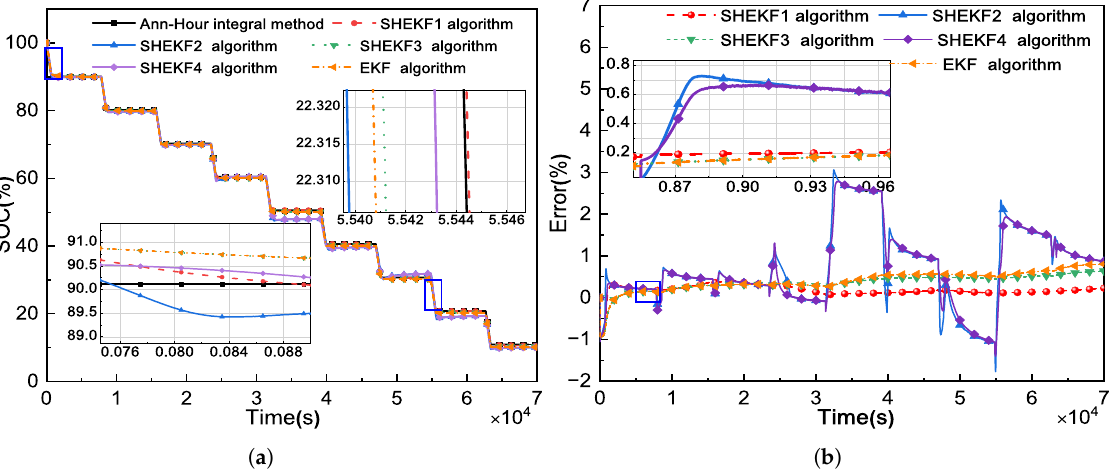
Figure 8. Algorithms comparison and its error curve with correct SOC initial value: ( a ) SOC, ( b ) Error.